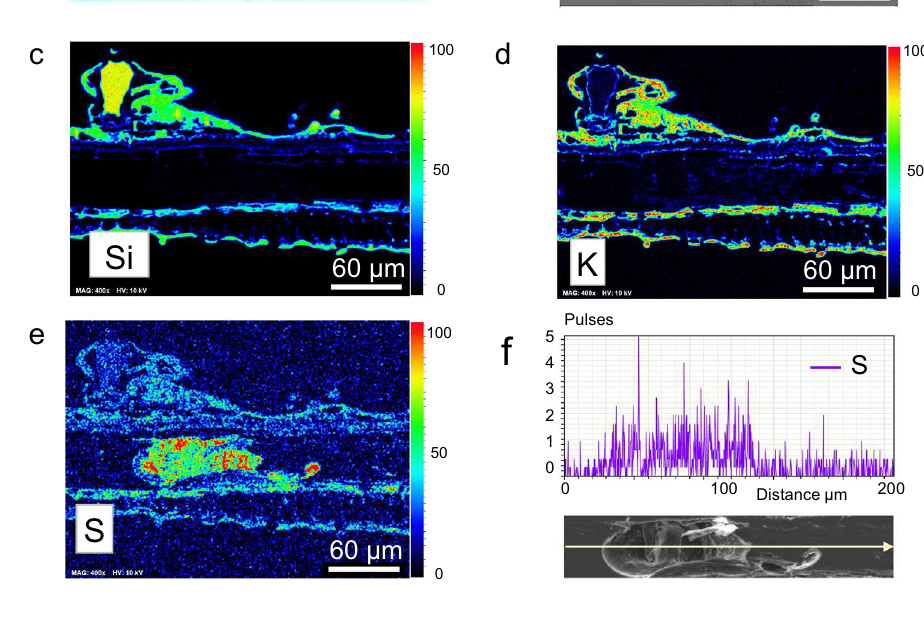
Fig. 3 Foliar transverse section with two large bulliform cells in the adaxial leaf surface (Primavera-10). a Light micro- scope picture; b SEM image with two delineated AOIs (AOI 1 showing the background); c Intensity of Si in the AOIs; d EDS map of Si with the left side bulliform cell also shown in larger magnification. Abbre- viations: b = bulliform cell, c = costal zone, cu =